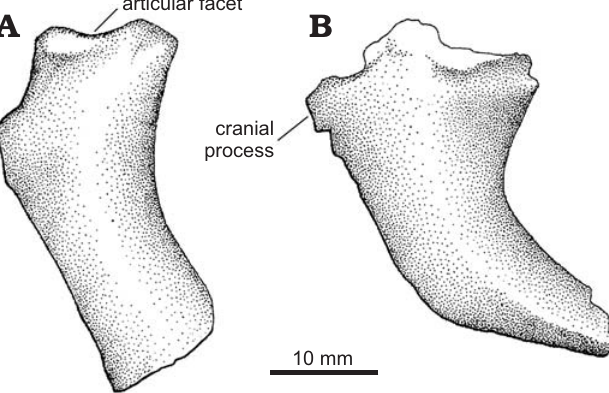
Fig. 2. Unenlagiid theropod Neuquenraptor argentinus Novas and Pol, 2005 (MCF PVPH 77) from Sierra del Portezuelo, Neuquén Province, Argentina; Portezuelo For mation, Coniacian, Late Cretaceous; two iso- lated proximal haemal arches in left lateral view.